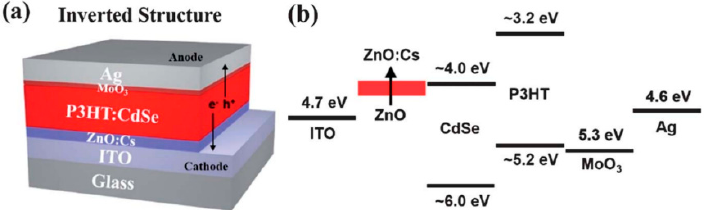
Figure 11. ( a ) An inverted structure of a BHJ solar cell composed of CP & QD blend; ( b ) the arrangement of energy levels of the materials used in the solar cell. Reproduced from [52] with permission of the Royal Society of Chemistry.